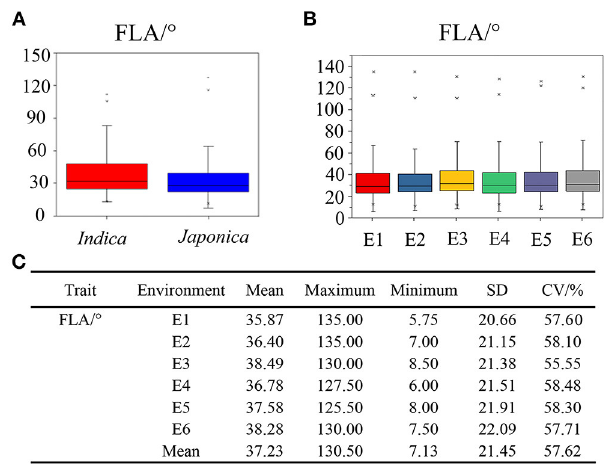
FIGURE 1 | Phenotypic characteristics of flag leaf angle (FLA) in indica subgroup, japonica subgroup, and six environments, respectively. (A) Phenotypic value distributions of FLA in indica subgroup and japonica subgroup. The number of varieties within each population was 172 and 181, respectively. (B) Phenotypic value distributions of FLA in six environments. (C) Phenotypic statistics of FLA in six environments. The box edges represent the upper and lower quantiles, with the median value shown by the black line in the middle of the box. Vertical lines represent the data from the lowest quantile to the top quantile. Individuals falling outside the range of the whiskers are shown as asterisks. E1, Nanjing in 2017; E2, Nanjing in 2018; E3, Nanjing